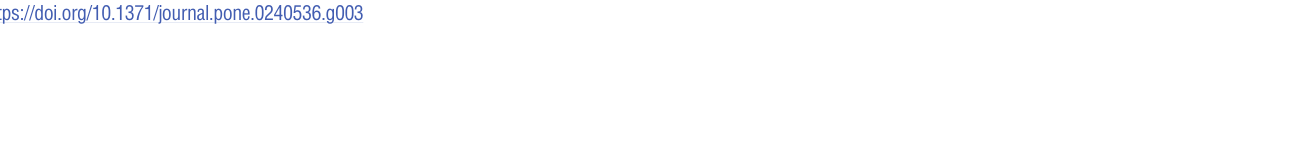
PLOS ONE | https://doi.org/10.1371/journal.pone.0240536 October 15,